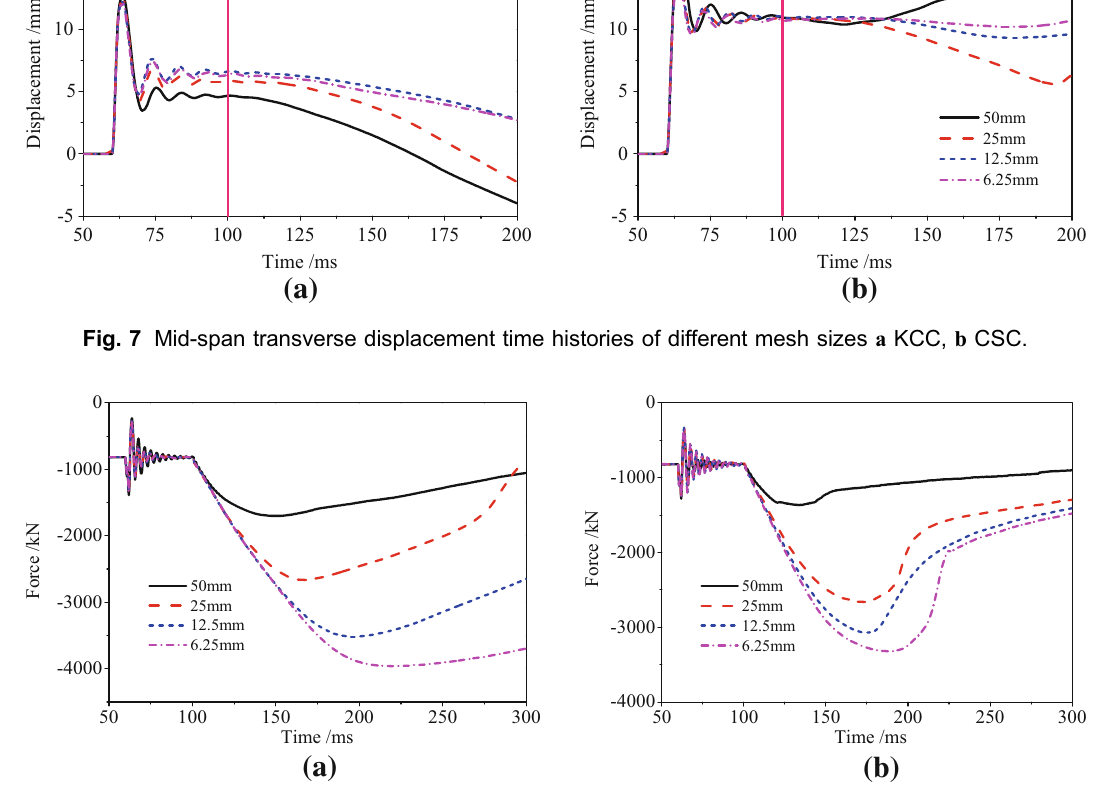
Fig. 8 Axial force time histories of different mesh sizes a KCC, b CSC.